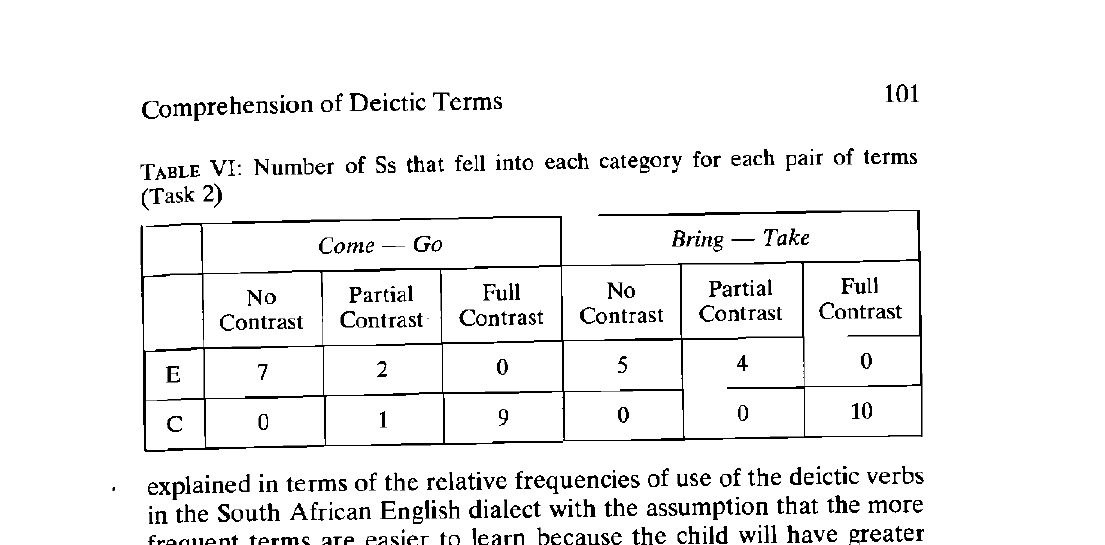
TABLE VI: Number of Ss that fell into each category for each pair of terms (Task 2) Come — Go Bring — Tak 0 Full Partial No Full Partial No Contrast Contrast Contrast Contrast Contrast Contrast 4 0 Ε 7 2 0 5 0 C 0 1 9 0